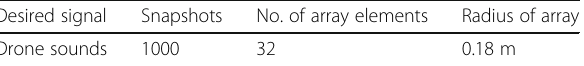
Table 3 Parameters for